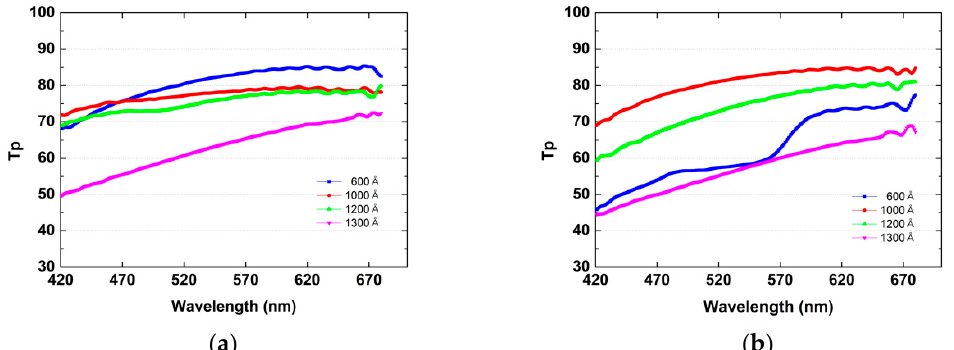
Figure 9. Comparison of transmittance according to Master mold pattern depth. ( a ) Ion Milling etch once ( b ) Ion Milling etch twice.